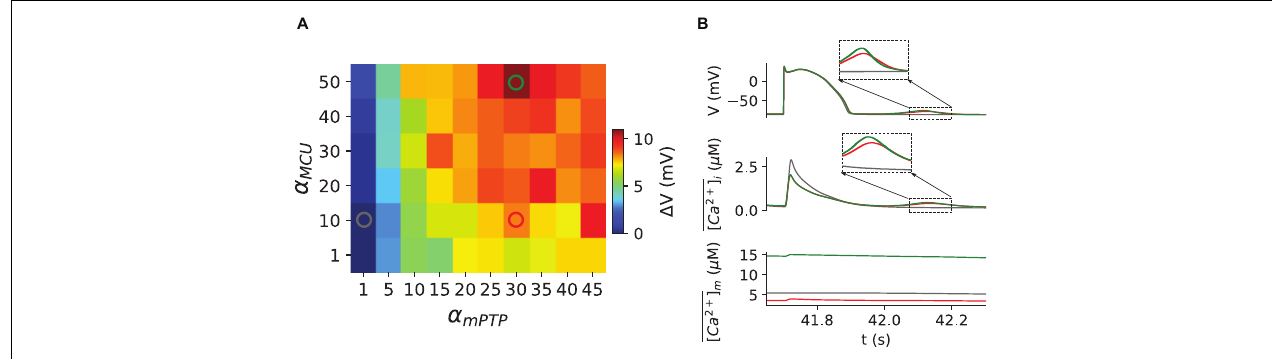
FIGURE 3 | Mitochondrial Ca 2 + Uniporter upregulation enhances the genesis of DADs through Ca 2 + - dependent opening of mPTP. (A) Dependence of the DAD amplitude on α MCU and α mPTP . (B) Time traces of V, (cid:2) Ca 2 + (cid:3) , and (cid:2) Ca 2 + (cid:3) for the ( α mPTP , α MCU ) coordinates as marked in panel (A) , following the same color i m codes. The zoomed-in sections of DAD and spontaneous Ca 2 + oscillation are shown in the corresponding insets.